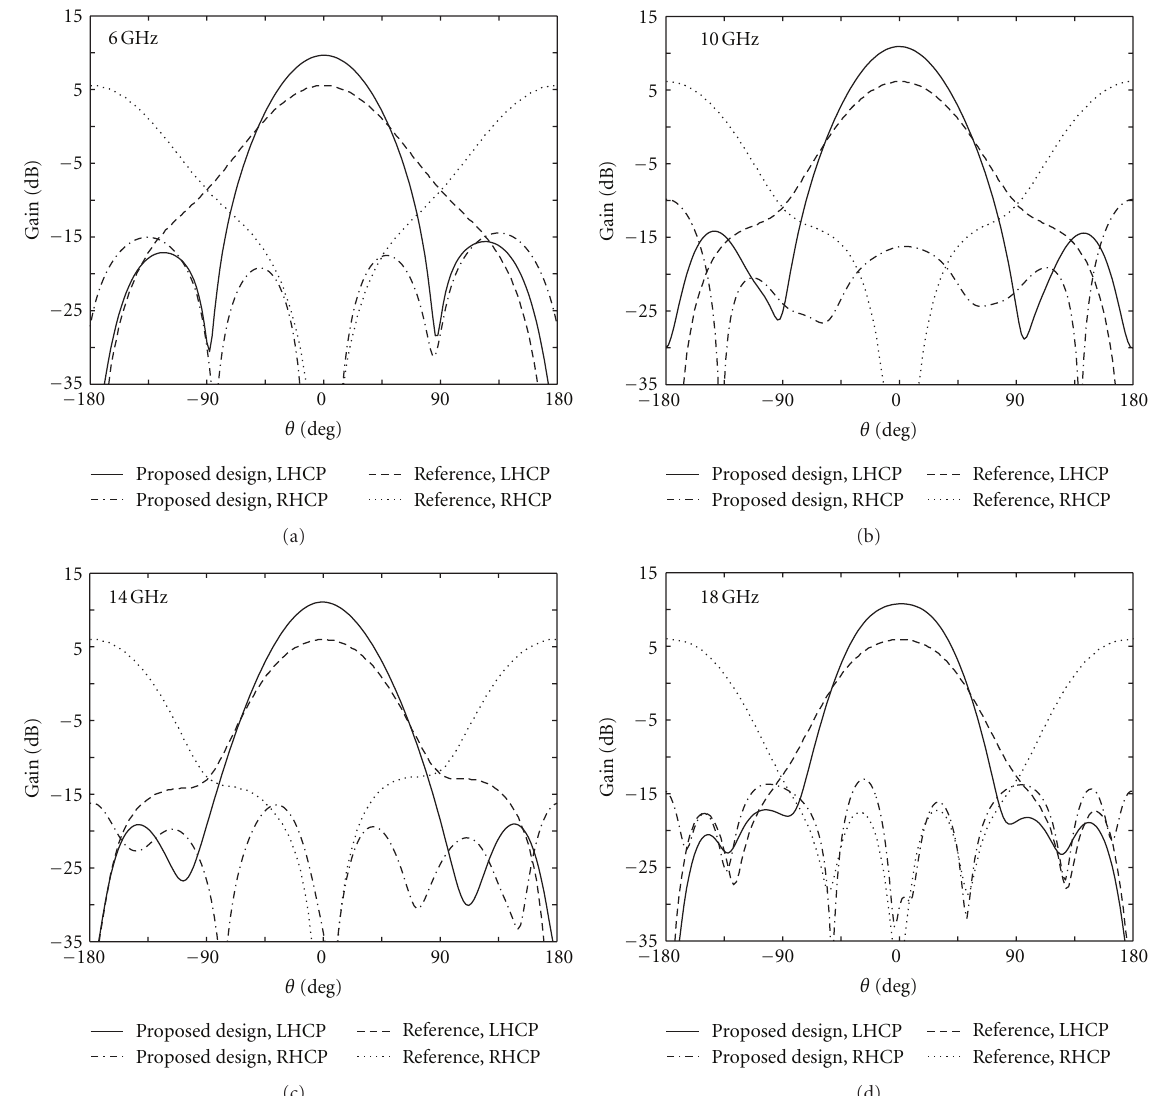
Figure 8: Simulated far-field patterns of the proposed slot structure at φ = 0, compared to the free space sinuous antenna